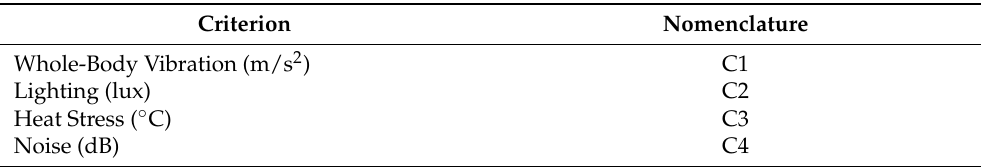
Table 2. Criteria in the case study.